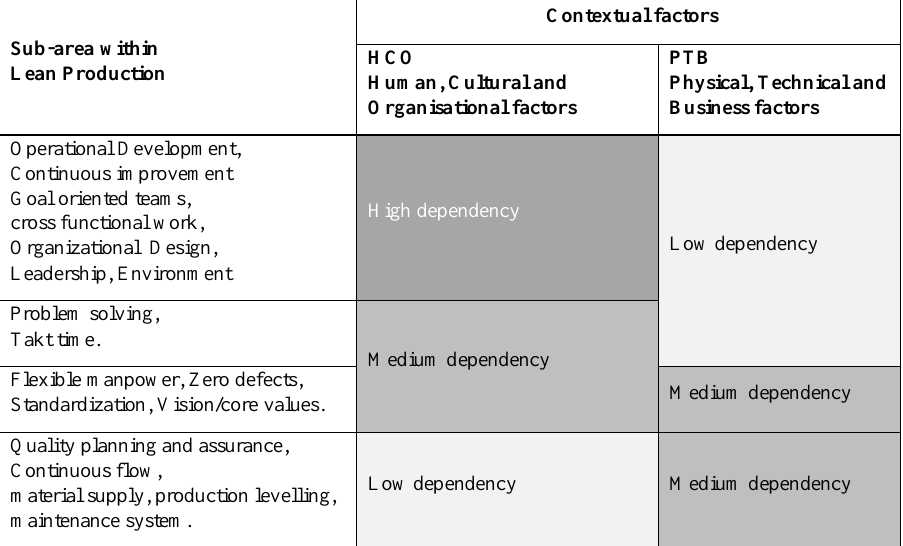
Table 3 – Contextual factors dependency on successful implementation of Lean methods Sub-area within Lean Production